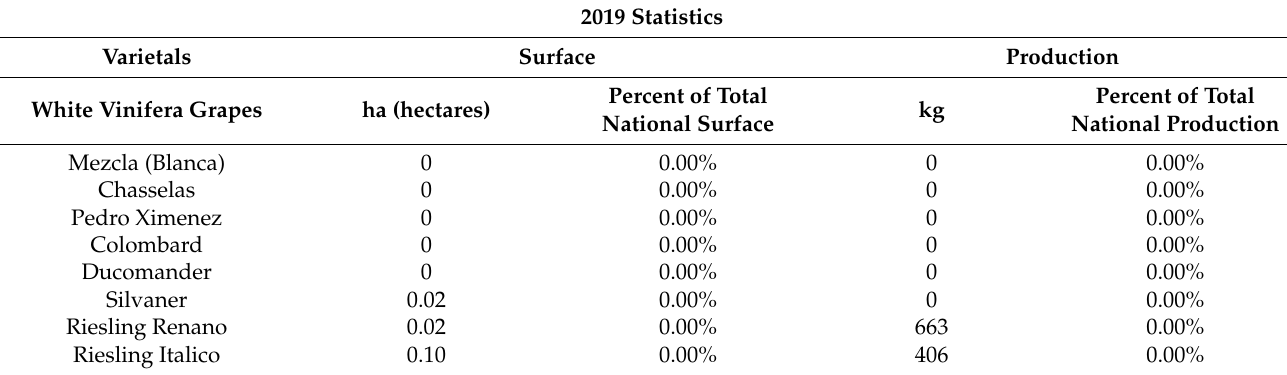
Table 6. List of white grape varietals currently cultivated and vineyard surface in